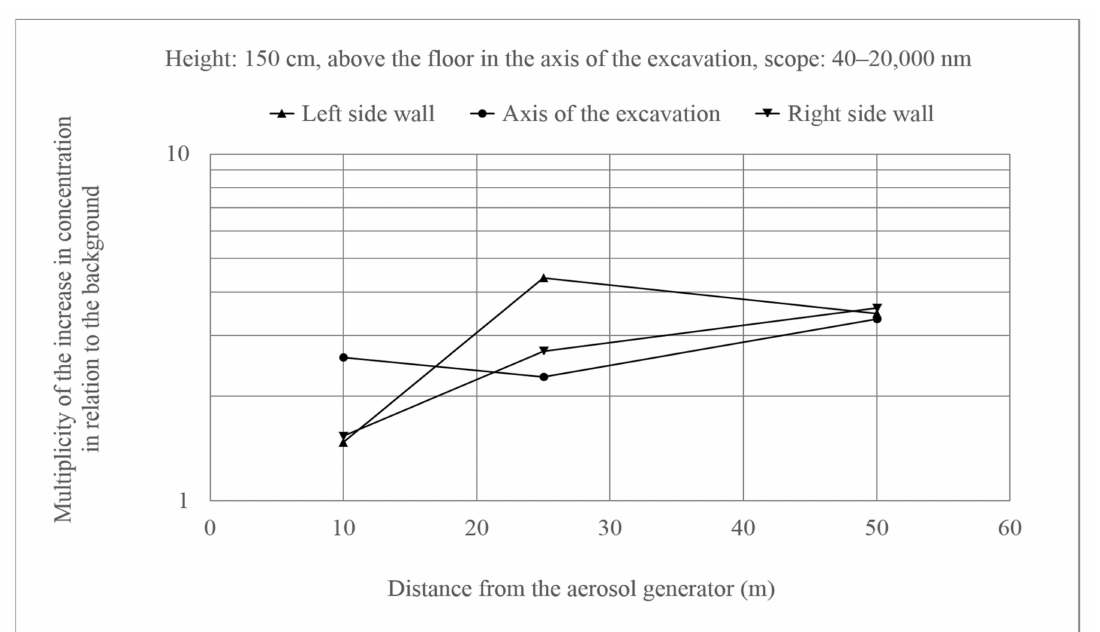
Figure 9. Increase in the concentration of aerosols of the size 40–100 nm at 150 cm above the floor in relation to the background. Generator efficiency: 17 cm 3 solution/min (Variant